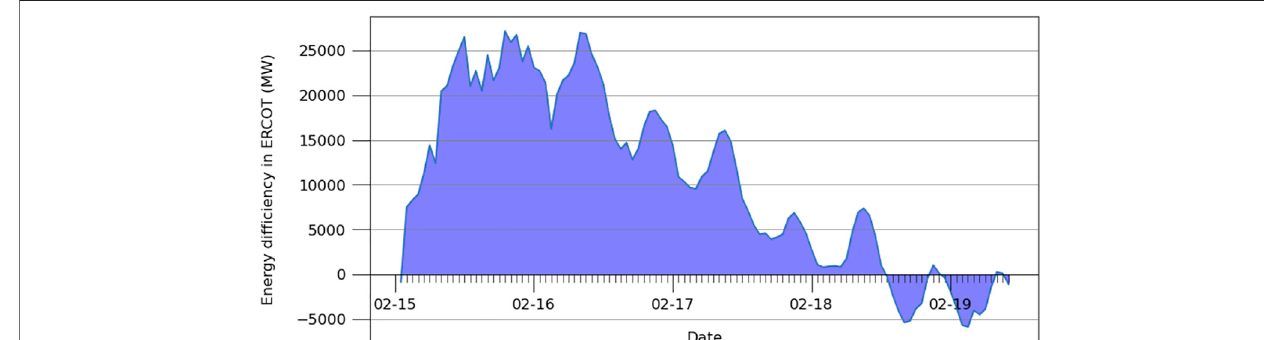
FIGURE 8 | Energy de fi ciency in ERCOT during EEA.